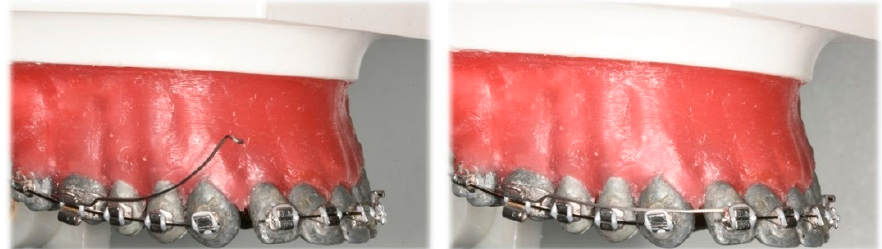
Figure 8. Three-piece intrusion arch. Deep curve shape cantilevers activated for anterior segment intrusion cantilevers: ( Left ) activated, before ligation; ( Right ) ligated distally to lateral incisors.